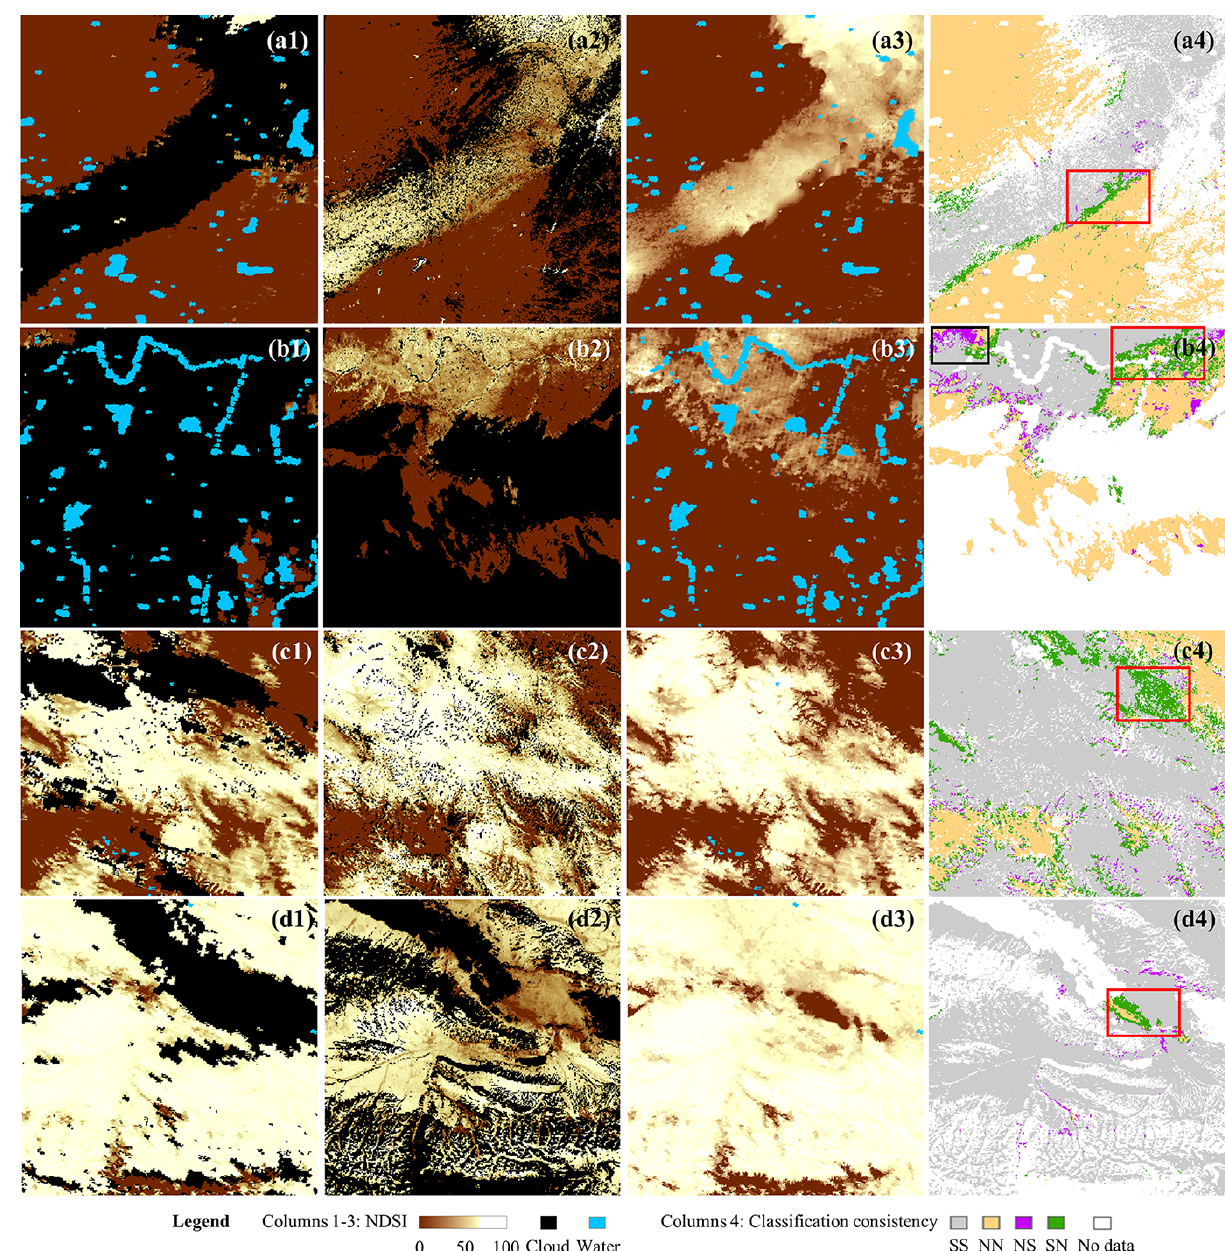
Figure 6. Comparison of TAC NDSI (column 1), Landsat NDSI (column 2), and STAR NDSI (column 3) products, and classification consistency (column 4) corresponding to NC3_20180311, CCR2_20180203, QTP2_20180225, and NX4_20180103 (groups a to d